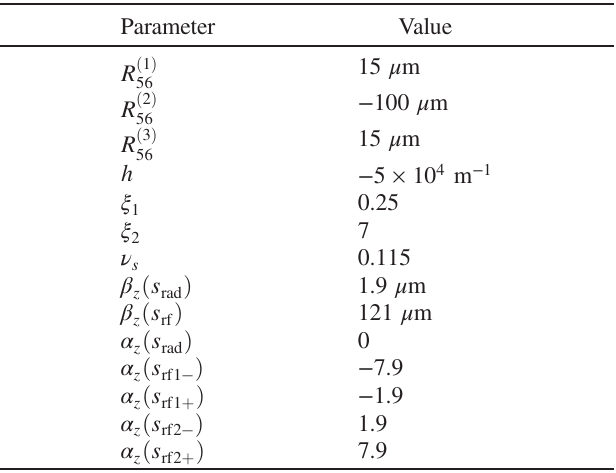
TABLE II. An example parameter set corresponding to the setup shown in Fig.